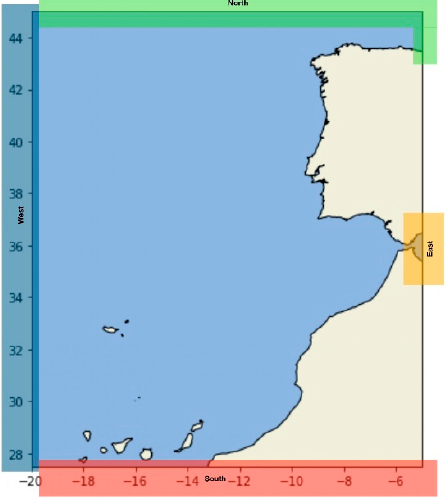
Figure 6. Map of the model domain and the location of each designated boundary: north (green box), south (red box), west (blue box) and east (yellow box). Table 2. The fraction of particles crossing the northern, southern, eastern, and western boundaries of the model, at the surface, a depth of 30 m, and a depth of 800 m. The boundaries are show in Figure 6. Release Depth